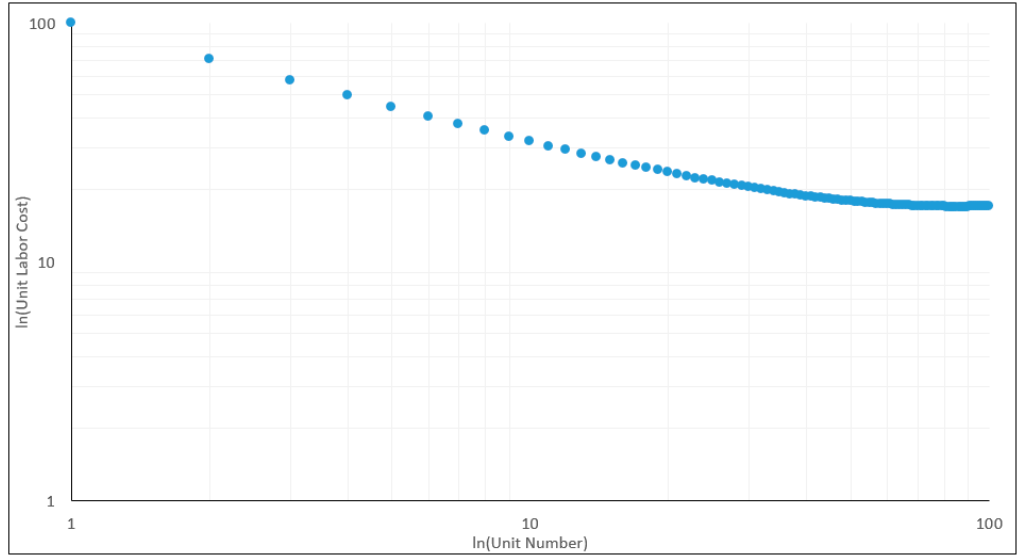
Figure 2. Unit Theory learning curve with a Decaying Learning Curve Slope.